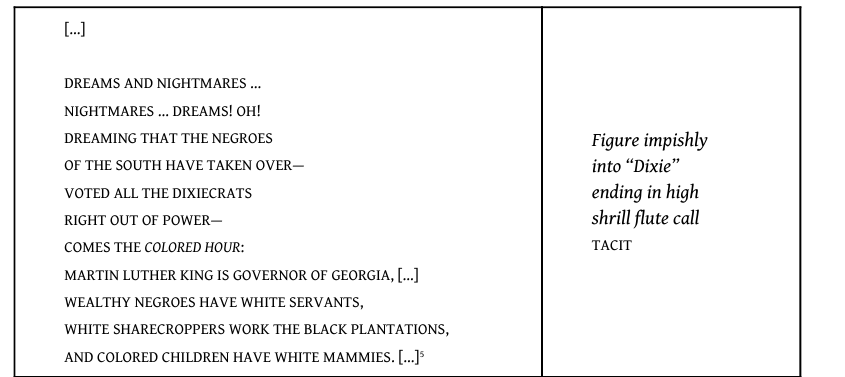
Figure impishly into “Dixie” ending in high shrill flute call